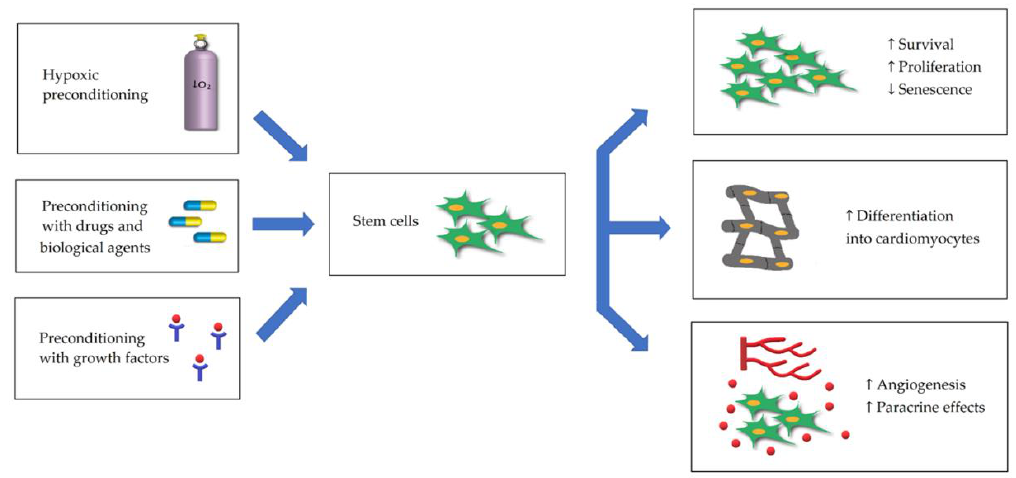
Figure 1. Preconditioning strategies to improve myocardial infarction stem cell therapy. Hypoxic preconditioning, preconditioning with drugs / biological agents and growth factors have been utilized to improve survival and proliferation, enhance differentiation, increase paracrine activity and angiogenesis.